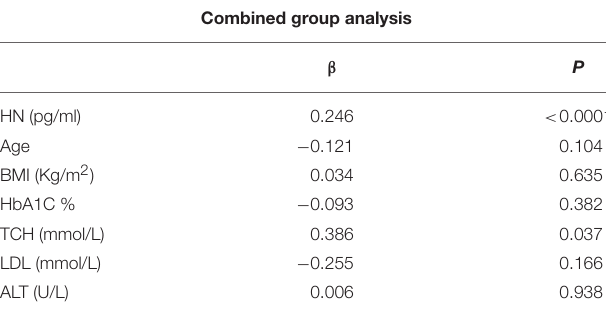
TABLE 2D | Multiple linear regression analysis of variables that showed significant association with MOTS-c. Combined group